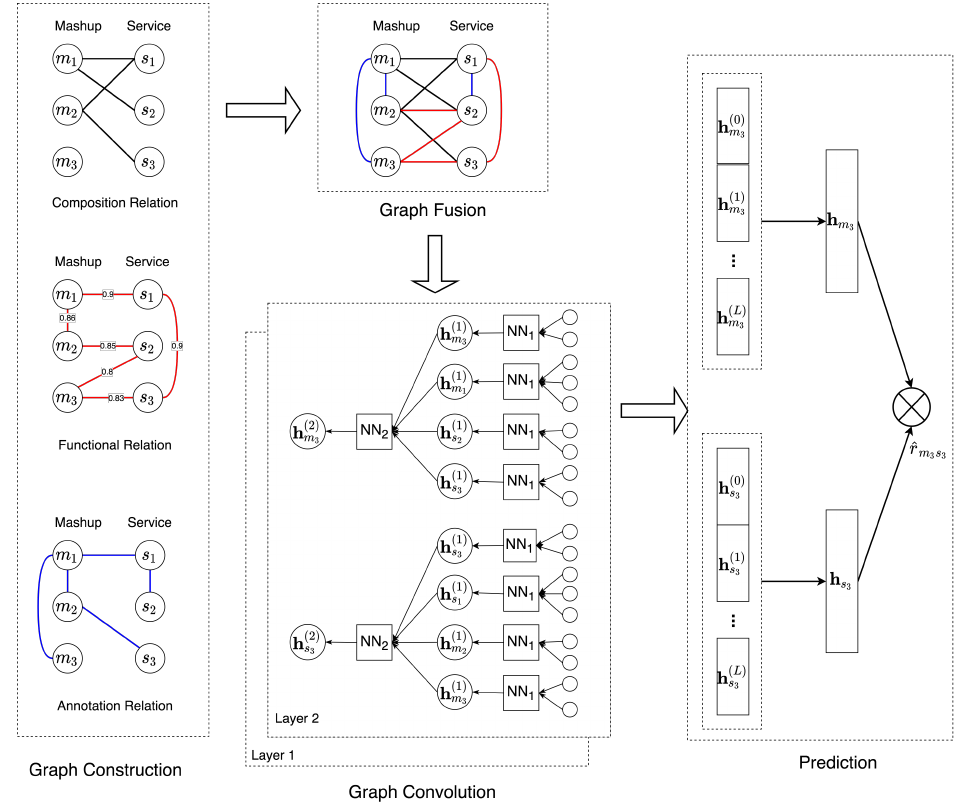
Figure 1. Overall framework of MRGCN for service